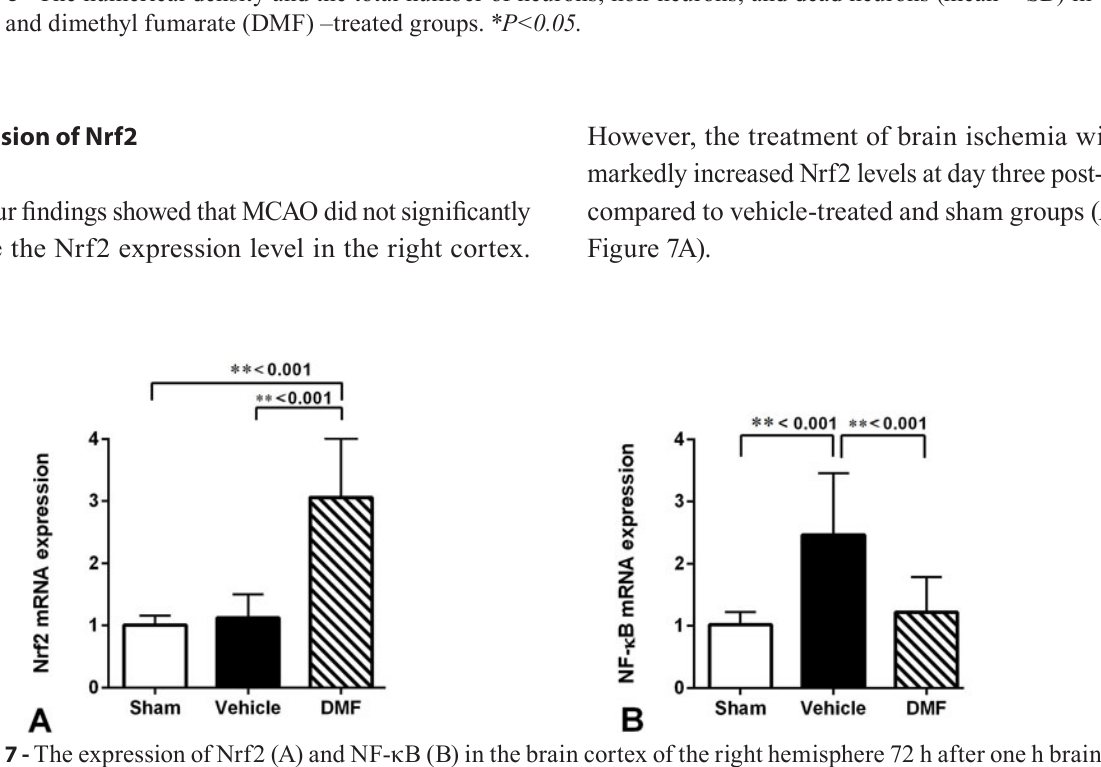
Expression of Nrf2